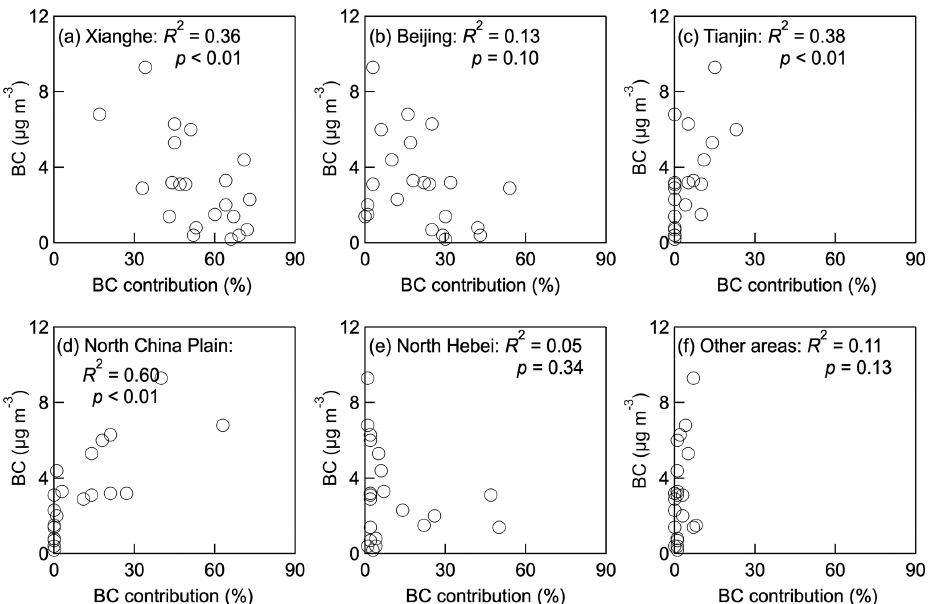
Figure 6. Scatter plots of the mass concentrations of total black carbon (BC) versus the BC contributions of different source regions obtained by WRF-Chem model. Table 2. Summary of names, numbers, and fractions of six types of elemental carbon (EC)-containing particles determined by a single- particle aerosol mass spectrometer.